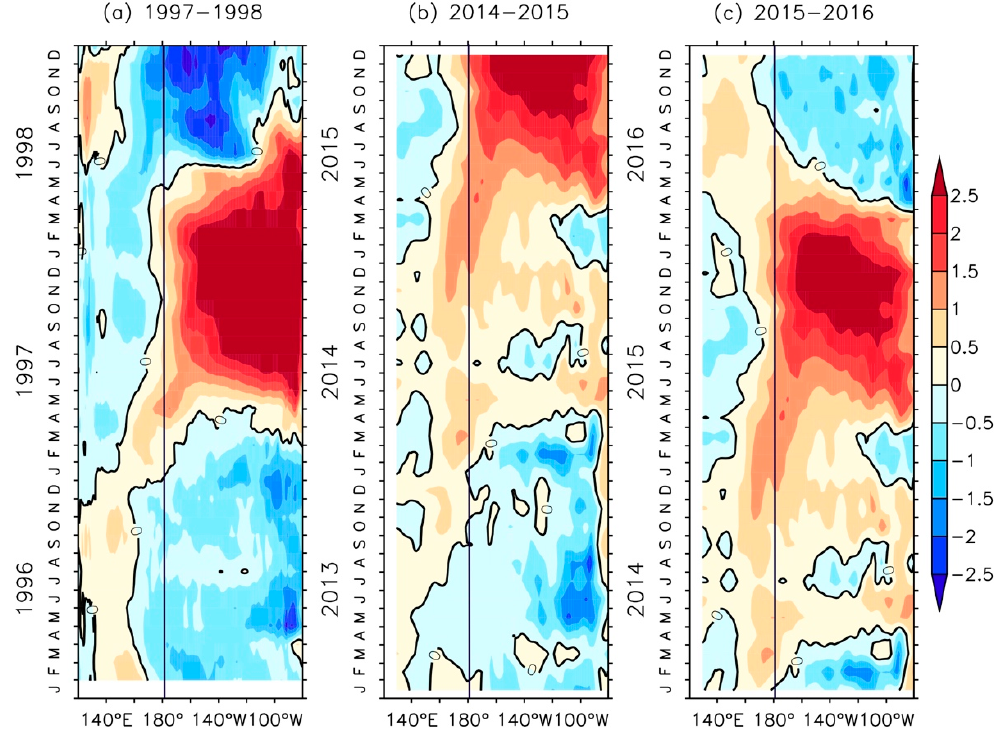
Figure 1. Longitude–time sections of sea surface temperature (SST) anomaly fields along the equator (averaging over 2 ◦ S–2 ◦ N) during ENs for ( a ) 1997–1998, ( b ) 2014–2015, and ( c ) 2015–2016. The vertical black line represents the location of the international the dateline. The units for SSTA are ◦ C.